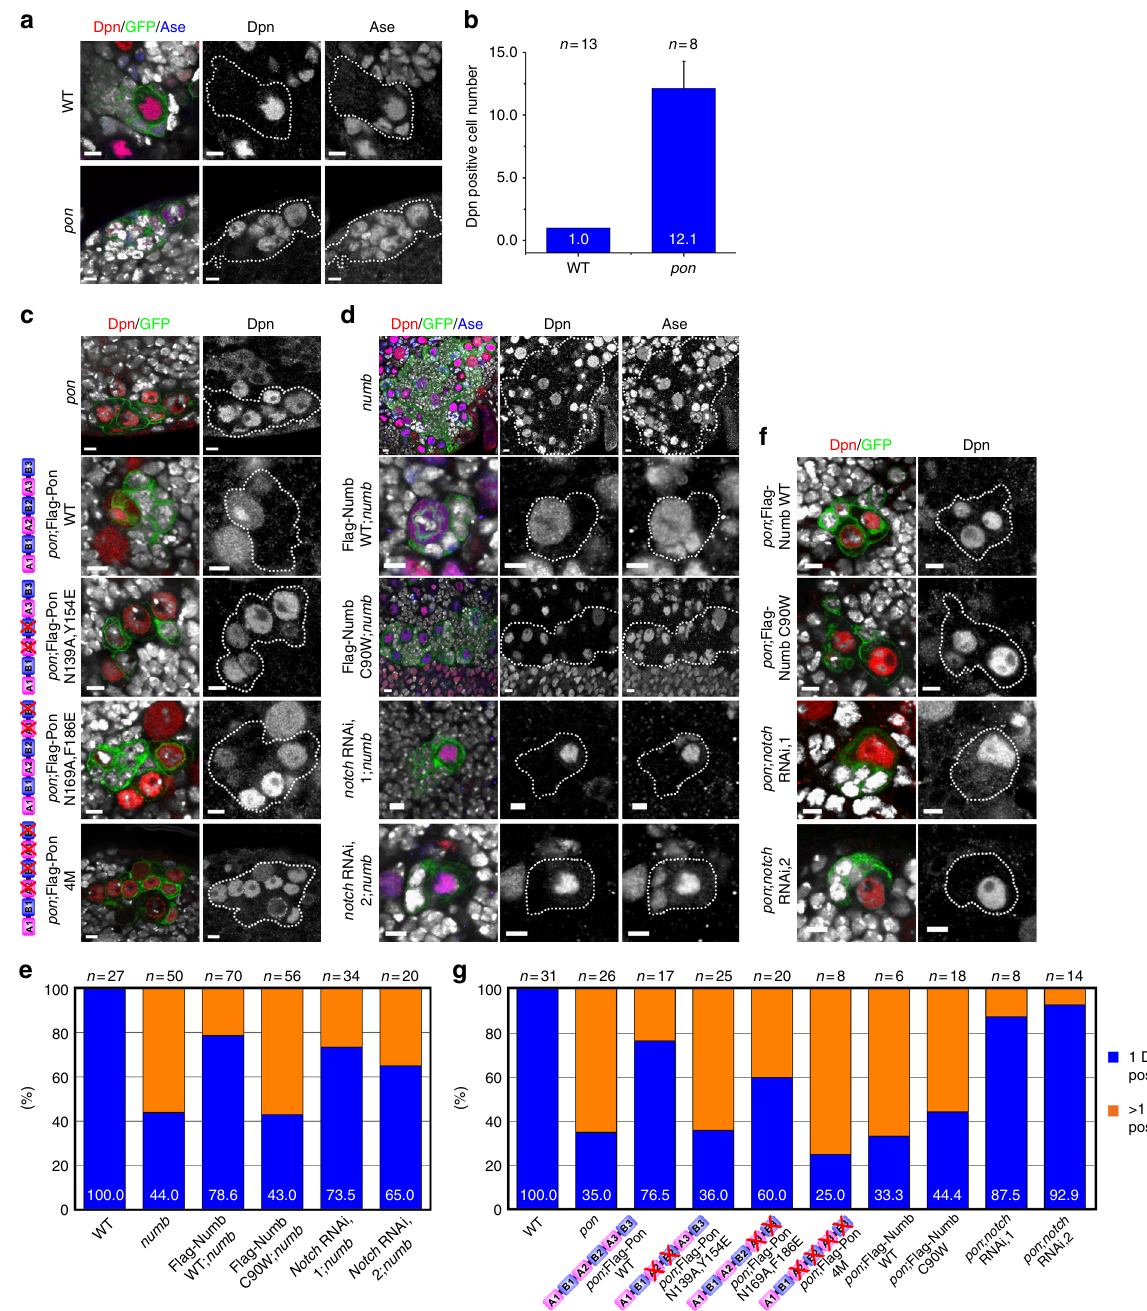
Fig. 8 Pon-Numb interaction is required for Numb function in inhibiting Notch signaling. a – f NBs are marked by GFP using MARCM technique. Dpn is in red, GFP in green, and Ase in blue. a pon mutant clone showing more Dpn- and Ase-positive NB-like cells than the wild-type counterpart. b Quanti fi cation of results in a showing that type I pon mutant NB clone (12.13 + 2.03, n = 8) in central brain contains more Dpn-positive cells, compared to WT clone (1.00 + 0.0, n = 13, p < 0.001, mean + SEM). Data are evaluated with Student ’ s t -test. c Rescue of pon mutant with Flag-Pon WT or variants. The over- proliferative phenotype of pon mutant clone could be rescued with Flag-Pon WT transgene, and partially rescued with Flag-Pon N169A , F186E transgene, but could not be rescued with Flag-Pon N139A , Y154E or Flag - Pon 4M transgene. d numb mutant NB lineage harboring multiple Dpn- and Ase-positive cells that is reverted by expression of Flag-Numb WT but cannot be rescued by the Pon-binding de fi cient Flag-Numb C90W variant. Introduction of notch RNAi (bl27988 for RNAi-1 and bl31180 for RNAi-2) could rescue the over-proliferative phenotype of numb mutant. e Statistical data for d . f The pon mutant phenotype could only be rescued by introducing notch RNAi, but not by expressing a Flag-Numb WT or Flag-Numb C90W transgene. Scale bars, 5 μ m. g Statistical data for c and